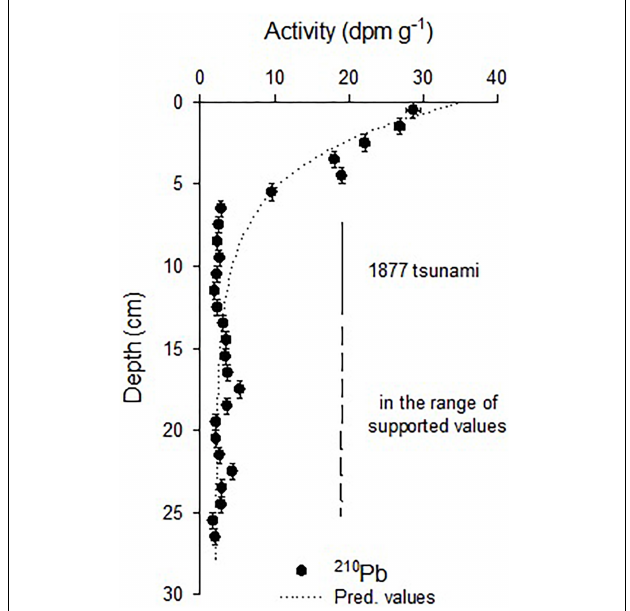
FIGURE 2 | 210 Pb activity distribution in the Z1A sediment core. Horizontal bars indicate the standard deviation of the measured activity and the vertical bars the thickness. The dotted line indicates the predicted values from the exponential decay model ( r 2 = 0.91; p < 0.01). Abrupt changes in the activities below 6 cm were coincident with older ages that fall in the range of the strong event reported in 1877 for the zone. Supported activities were found below the layer left by this